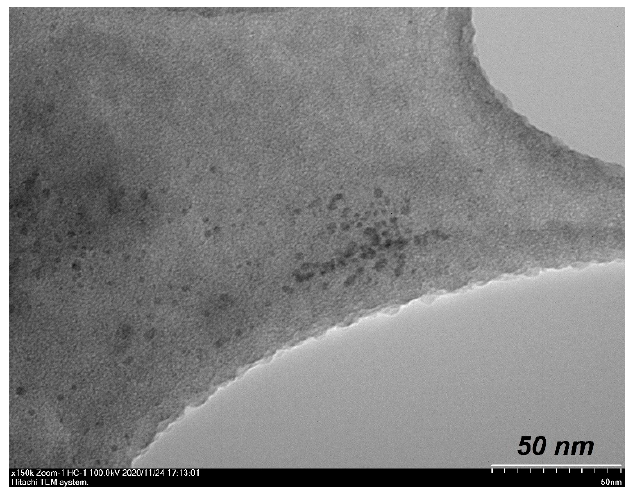
Figure 10. TEM samples prepared using the “nanofishing” procedure: Pd (OAc) 2 and 6b in ethanol.